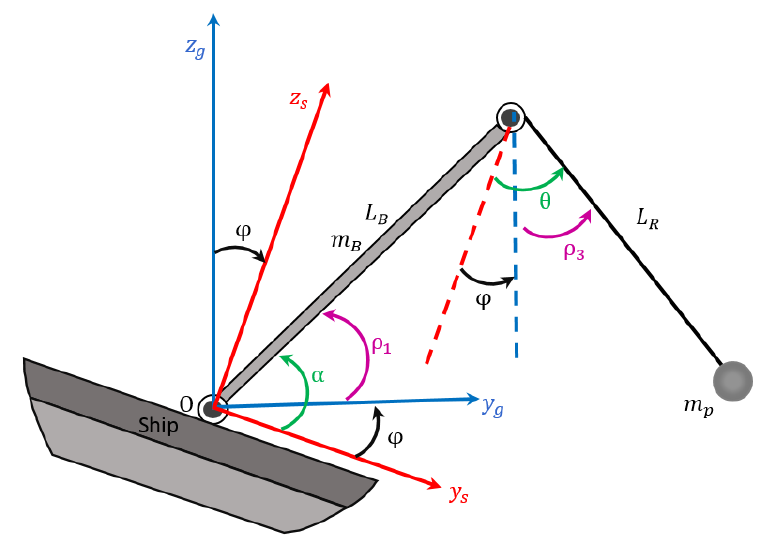
Figure 2. Sketch of a shipboard boom